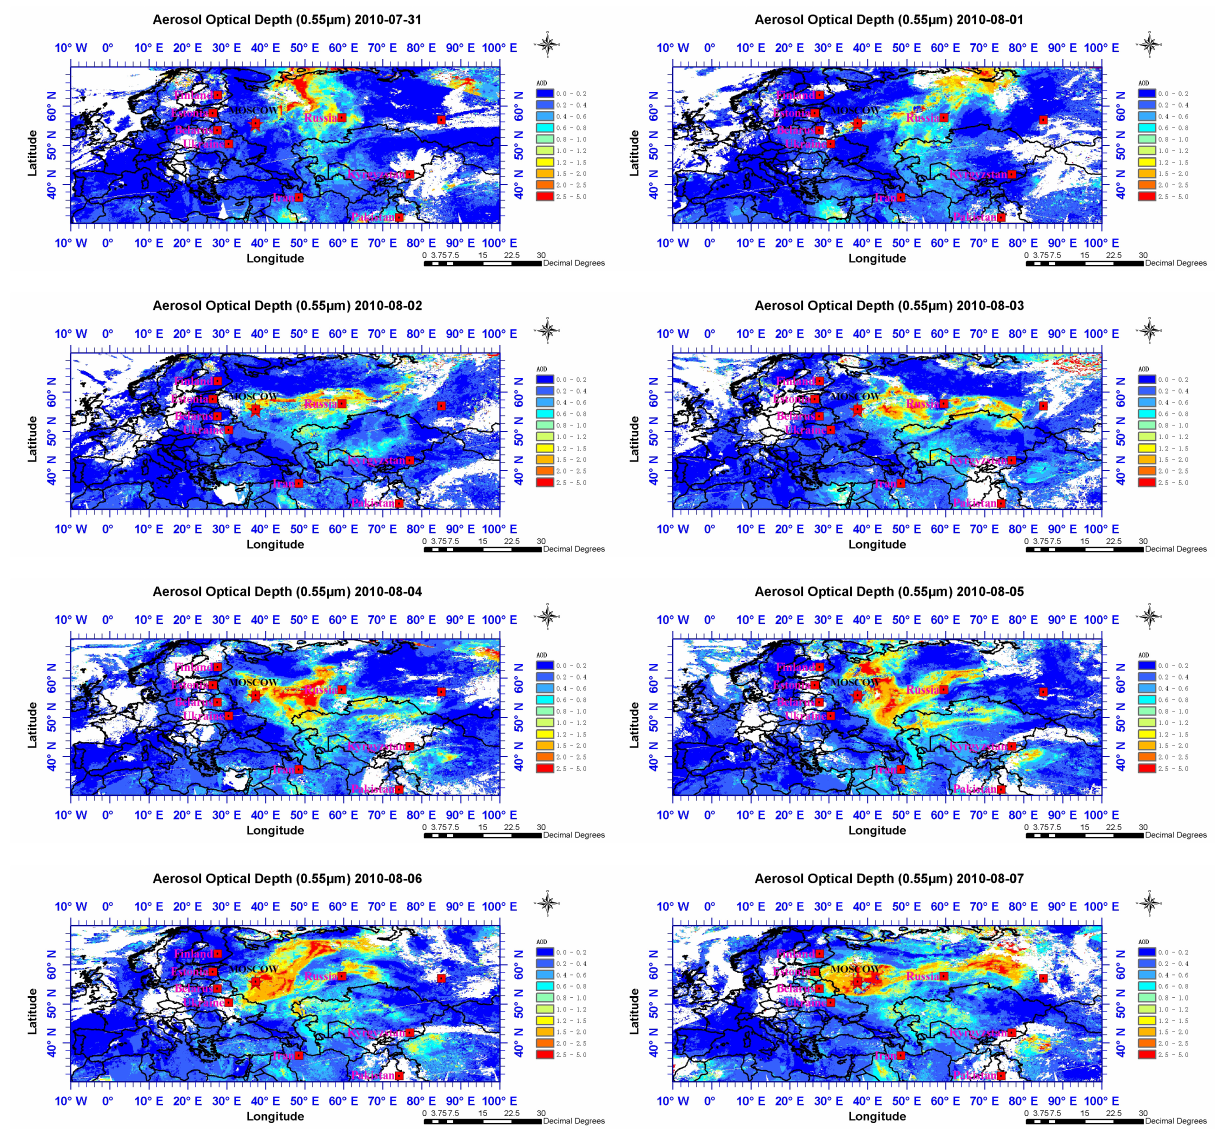
Fig. 5. PM 2 . 5 (in µgm − 3 ) distribution over the study area for the period from 31 July to 15 August 2010. The mean satellite-derived daily PM 2 . 5 concentrations were calculated from the methods as described in the